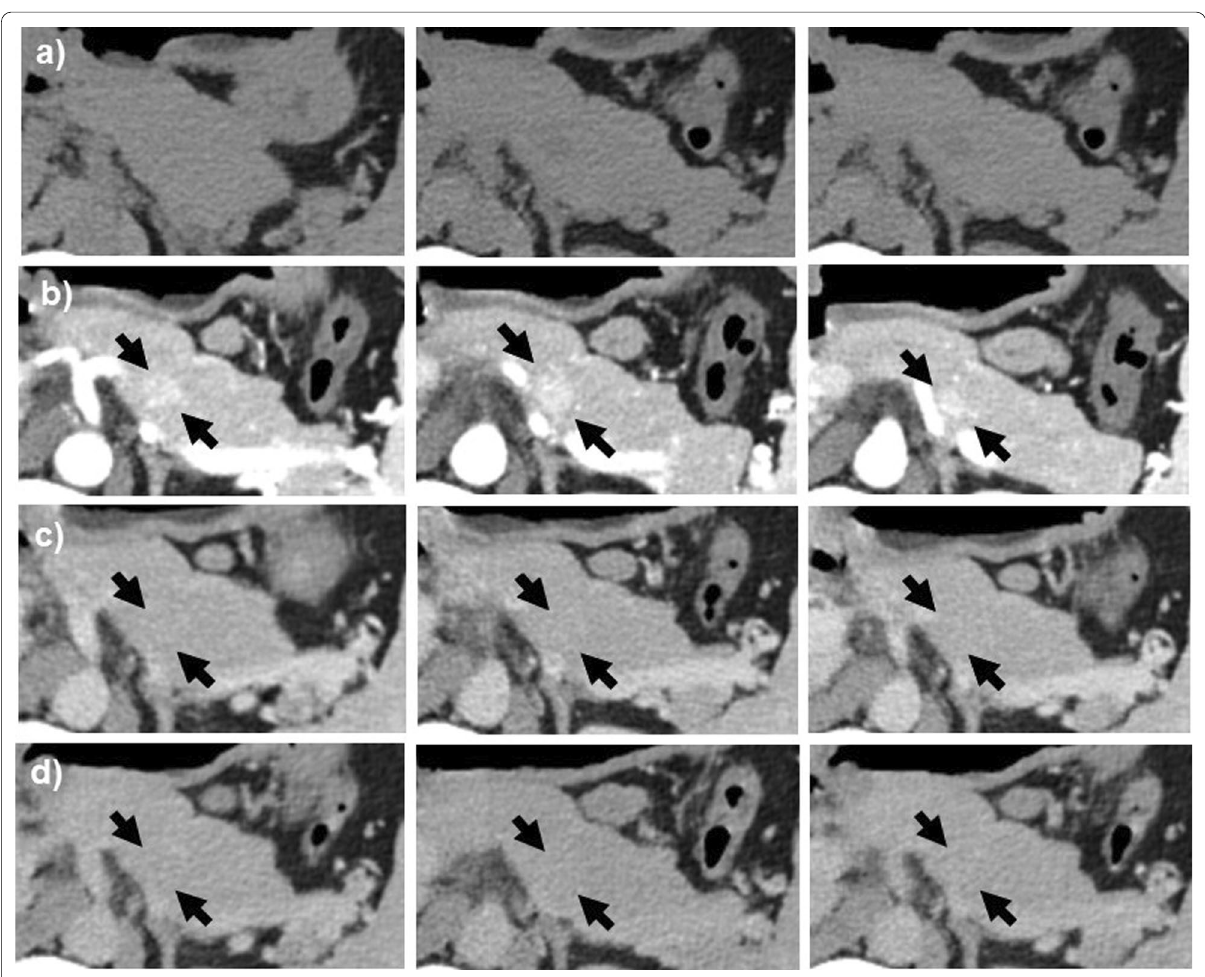
Fig. 1 Contrast-enhanced CT of the abdomen. a Plain CT, b arterial phase, c portal phase, and d equilibrium phase. A 13-mm-long well-defined mass was found in the tail of the pancreas. The tumor showed slight low density compared with the pancreatic parenchyma on plain CT ( a ) and enhancement in the arterial phase and equal density with the pancreatic parenchyma in the portal and equilibrium phases on dynamic enhanced CT (black arrows in b – d ). Tumor abutment to the splenic artery and vein without encasement was observed. No significantly enlarged regional lymph nodes and distant metastases were